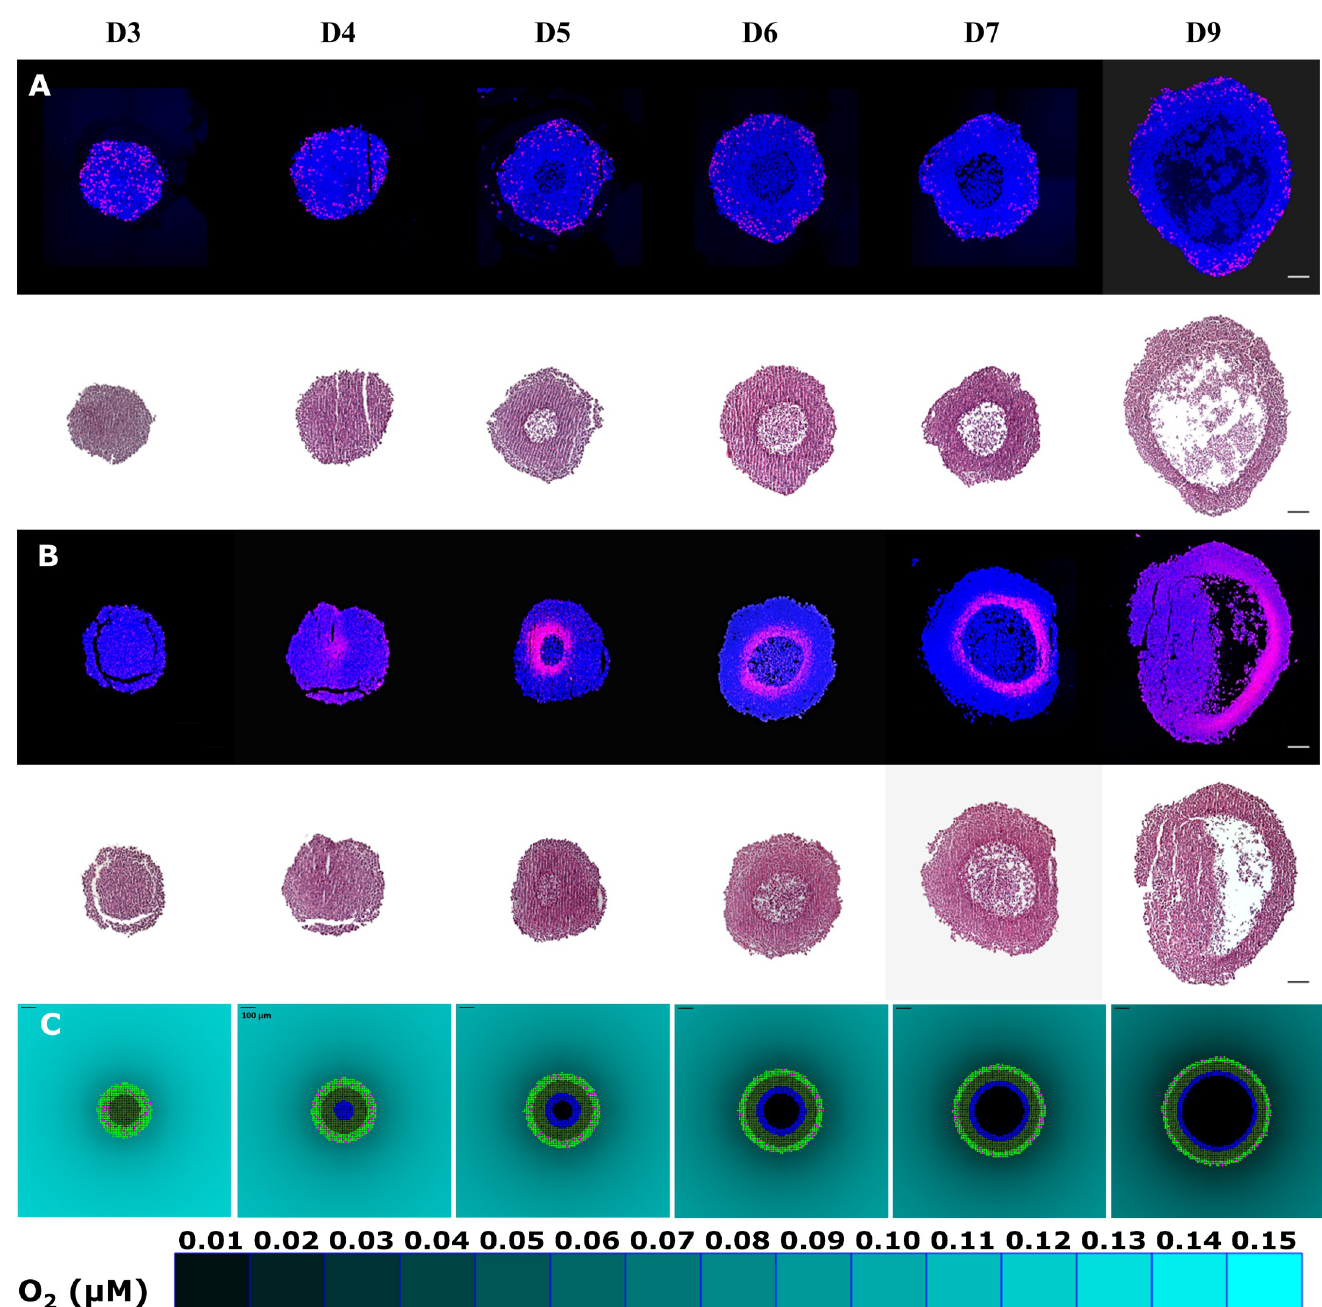
Fig 3. Histological characteristics of spheroids visualised in central sections and comparison with outputs of the SABM. S-phase cells in spheroids collected after the indicated days of growth were stained after incubation with EdU (panel A ). Hypoxic cells in spheroids were visualised by immunostaining for EF5 binding (panel B ). The same spheroid sections were stained with H&E to quantify the necrotic and viable rim size (lower panels of A , B ). n = 48 spheroids for A and B , respectively. Panel C shows SABM simulations based on oxygen and glucose parameters fitted to monolayer ad MCL experimental data (See Table 1). 2D snapshots of a central plane through spheroids are shown in which pink cells represent dividing cells, light green cells are highly proliferative cells under well oxygenated microenvironment ( > 1 μ M O 2 ), dark green cells are slowly proliferative cells under hypoxia ( < 1 μ M O 2 ), blue cells have been hypoxic for > 24 hr and have been tagged for subsequent necrosis, and the black region in the centre represents the necrotic zone. Scale bars = 100 μ m and a color-coded legend for oxygen concentration in the medium is shown.